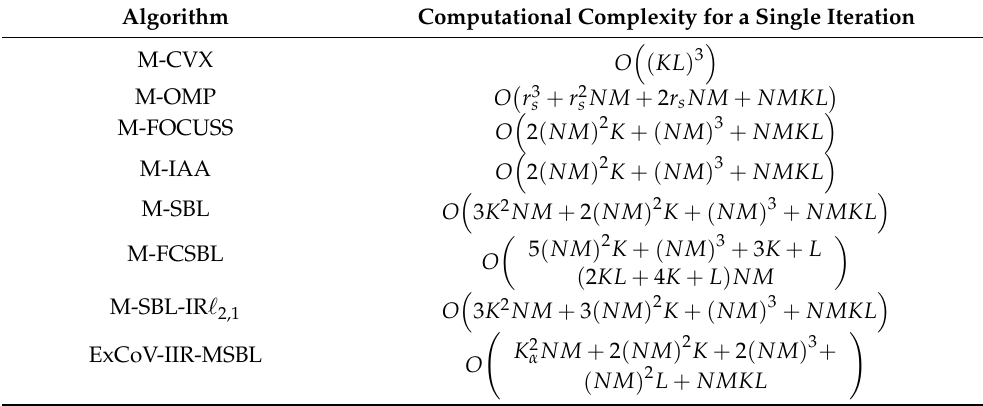
Table 1. Computational complexity comparison. Algorithm Computational Complexity for a Single